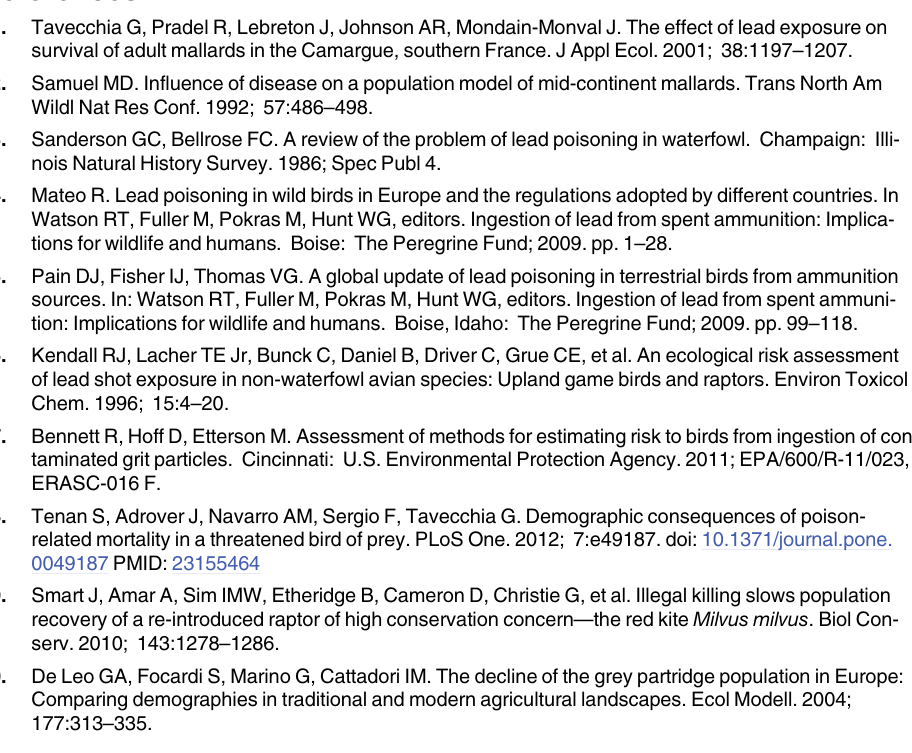
S2 Fig. Modeled density-dependent relationships for common buzzard and red kite. Rela- tionship between population size and per capita growth rate, r (= ln λ , where λ = annual popu- lation growth factor), for common buzzard and red kite is shown in (a). Relationship between fecundity (F#, where # is age class) and survival (S#) is also shown for common buzzard (b) and red kite (c). The vital rates in (b) and (c) produce the theta-logistic curves in (a). (TIF) S3 Fig. Relationship between per capita growth rate, r, and density of common snail kite breeding pairs in Florida, USA [56]. r = ln λ , where λ is annual population growth factor. The shape of the curve is described by theta ( θ ) in a theta-logistic equation [r = r is equal to 5.58 (where N = population size, K = carrying capacity, r θ indicates r does not decrease much until density is close to K, the steady-state population size (i.e., where the curve crosses the r = 0 line).